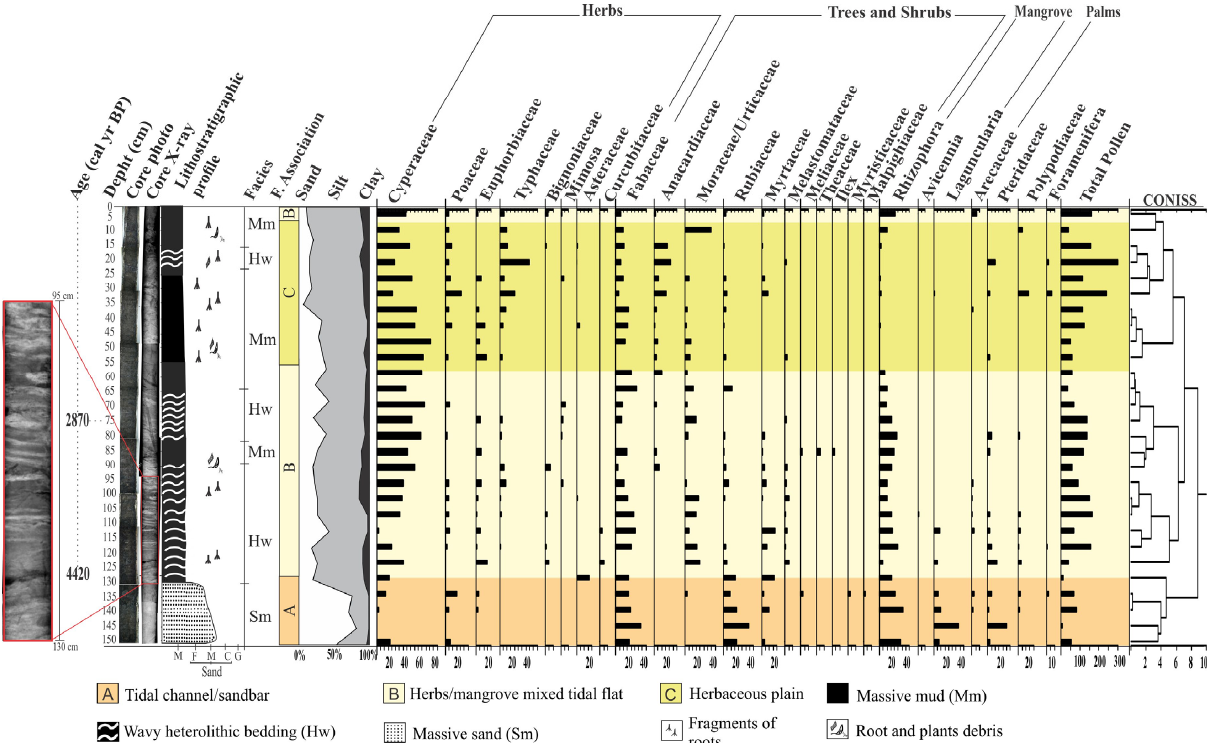
Figure 5. Pollen diagram of core NAT − 5, with percentages of the most frequent pollen rates, age of the samples, and cluster analysis.